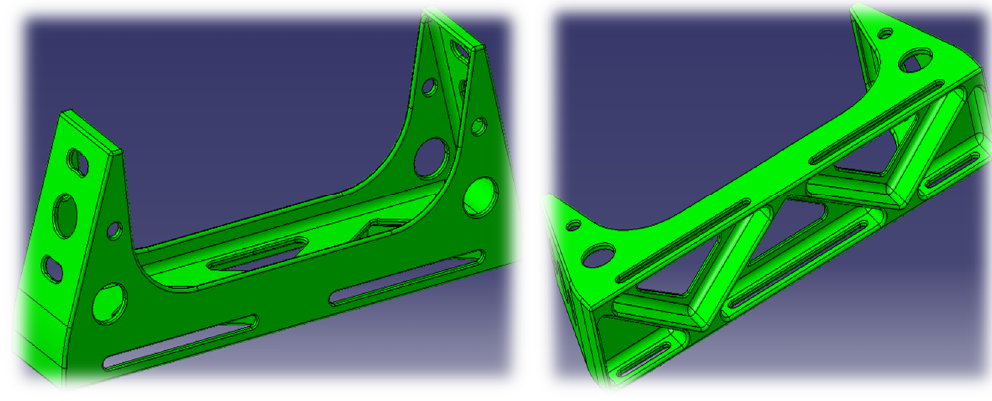
Figure 30. Front axle no. 2 in Solidworks environment.